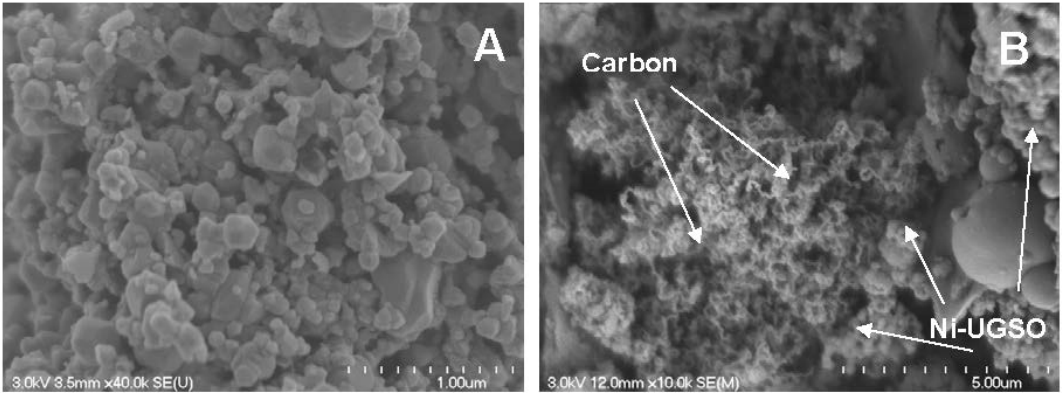
Figure 9. Micrographs of Ni-UGSO after bio-oil MemU SR at 800 °C: ( A , B ) WHSV = 1.7 g/g cat /h; and ( C , D ) WHSV = 6.6 g/g cat /h.